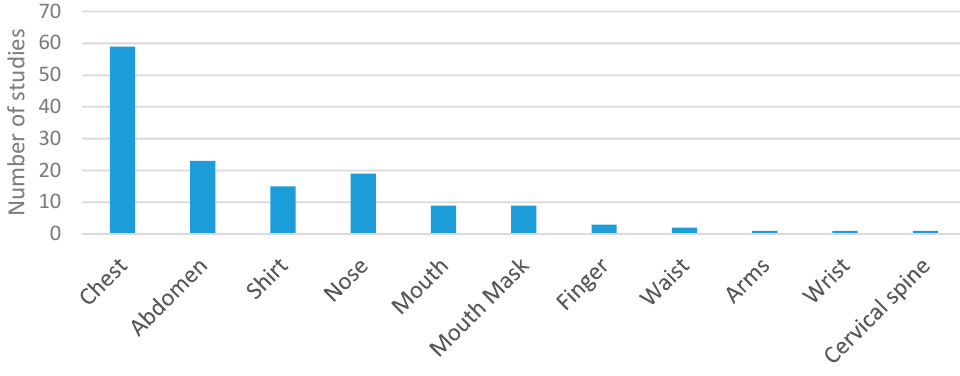
Figure 8. Number of studies obtaining the different respiratory parameters for the wearable ( top ) and environmental ( bottom ) categories.